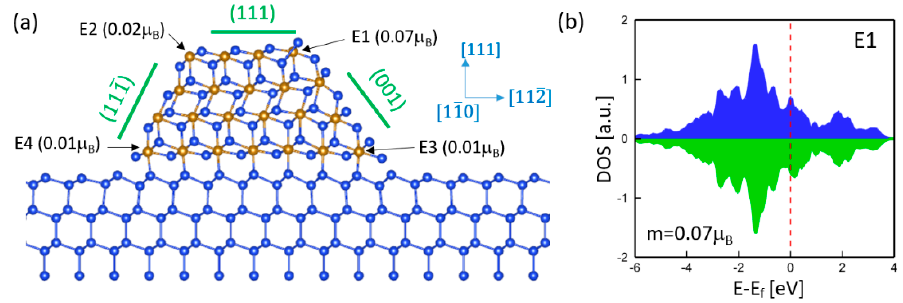
Figure 5. ( a ) Atomic structure and spin moments of γ -FeSi 2 /Si(111) epitaxial nanoislands with four Fe layers. The edges are denoted as E1, E2, E3, and E4, which are oriented along the 110 direction. ( b ) DOS of the Fe atom at edge E1.